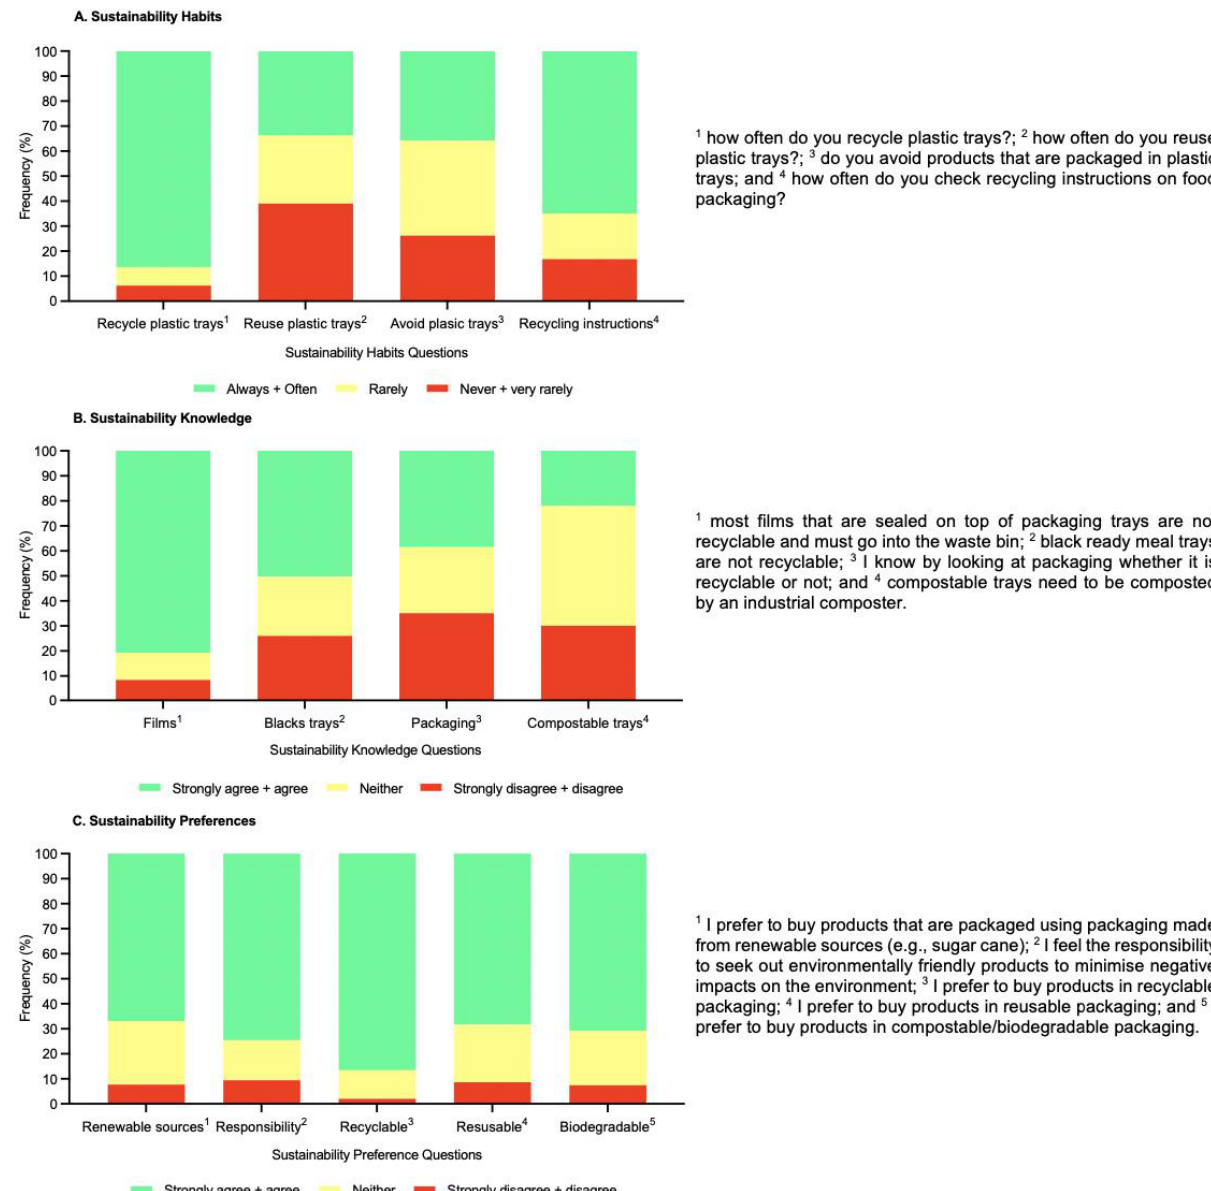
Figure 4. Consumers ( n = 405) sustainability question related data ( A ) sustainability habits; ( B ) sustainability knowledge; and ( C ) sustainability preferences) from five-point category scales.